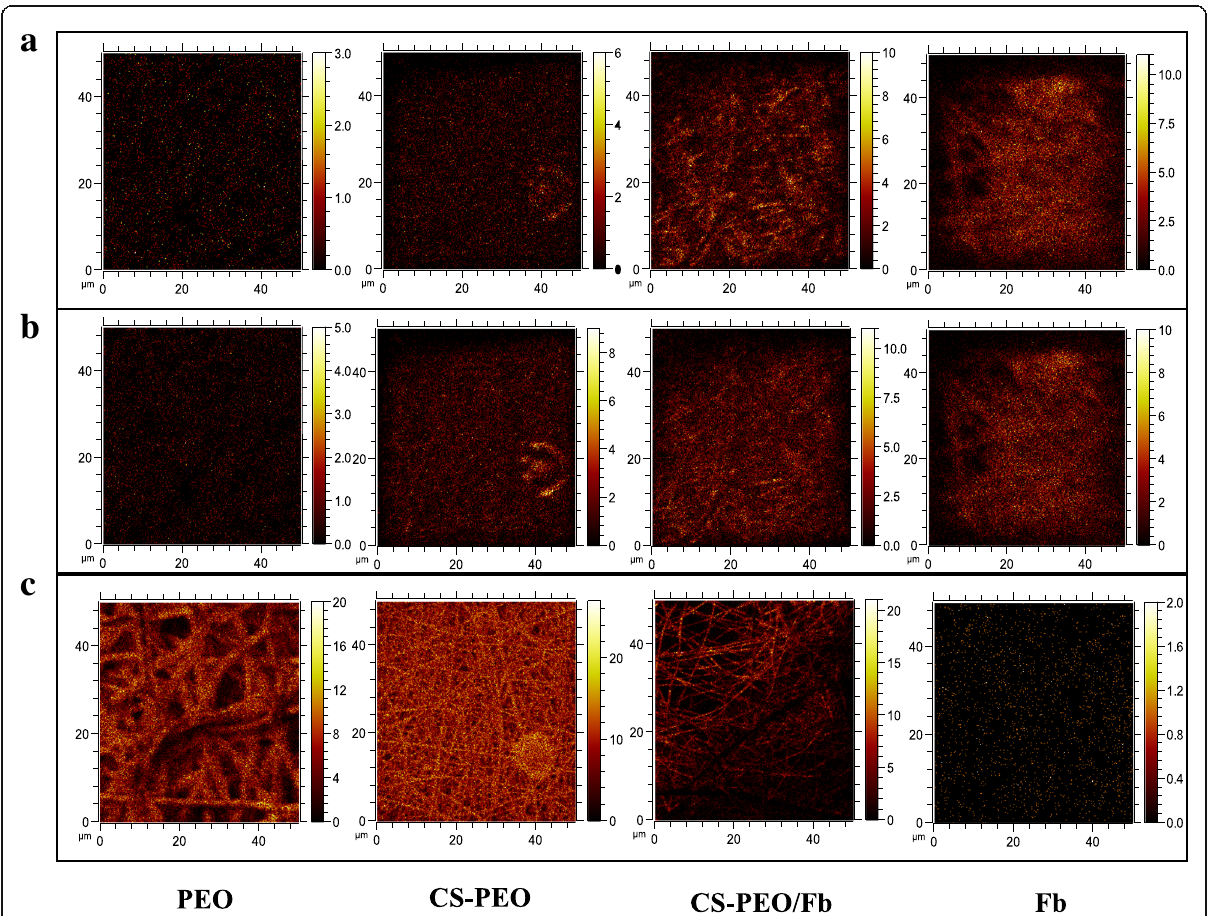
Fig. 4 ToF-SIMS mapping of a CNO − , b CN − , and c C 2 H 5 O + ion fragments on various scaffolds over a 50 × 50- μ m raster area